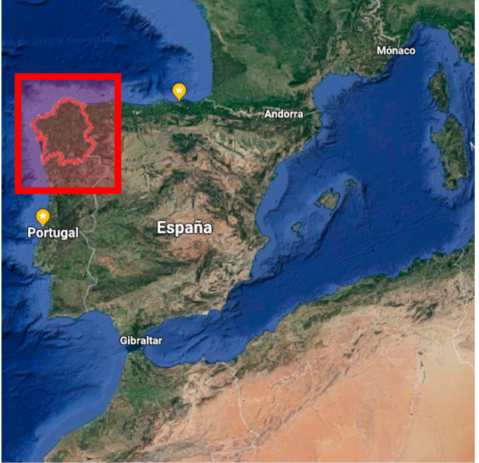
Figure 6. Galicia region (NW of Spain), in red.